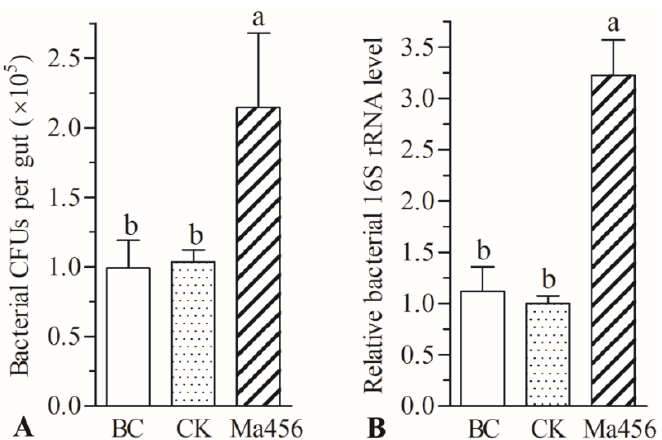
Figure 2. Bacterial CFUs count ( A ) and relative quantification of bacterial 16S rRNA ( B ) in the gut of BPH treated by topical spraying fungal conidia (Ma456), 0.02% Tween 80 (CK) and ddH 2 O (BC), respectively. Different letters on the bars of each group denote significant differences among BPH gut samples ( p < 0.05). Error bars: SD from three repeated assays. Table 1. Bacterial community alpha-diversity characteristics in the gut of BPH infected and uninfected with fungal